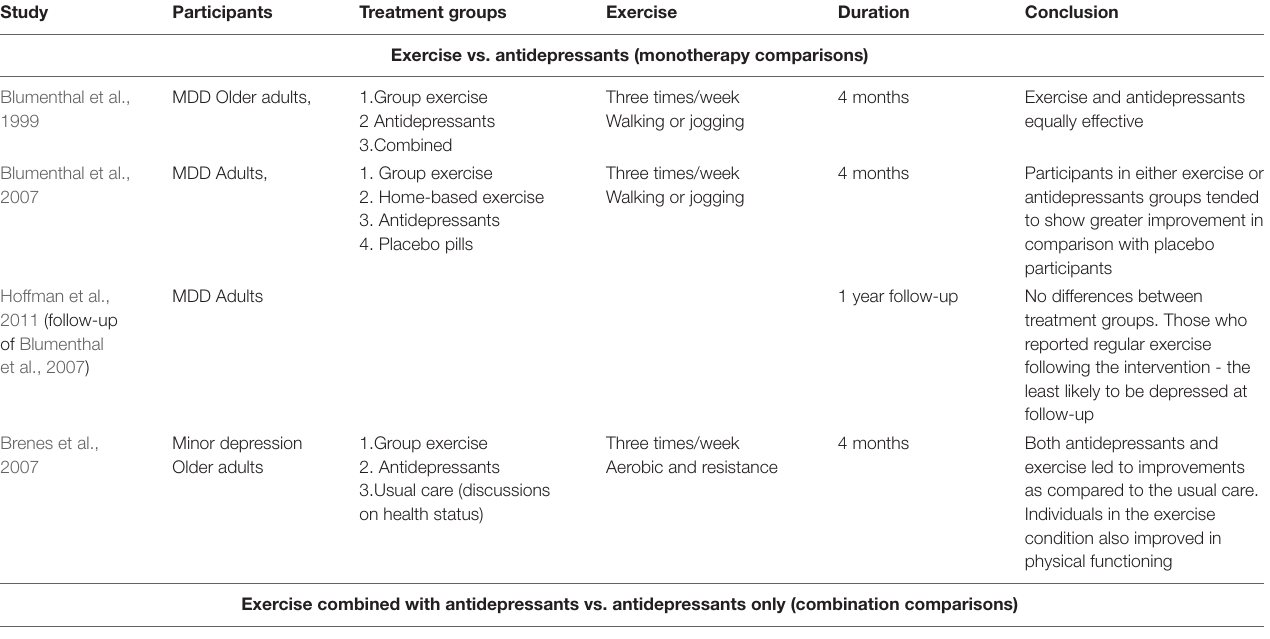
TABLE 1 | Randomized controlled trials (RCTs) comparing exercise to antidepressants in the treatment of